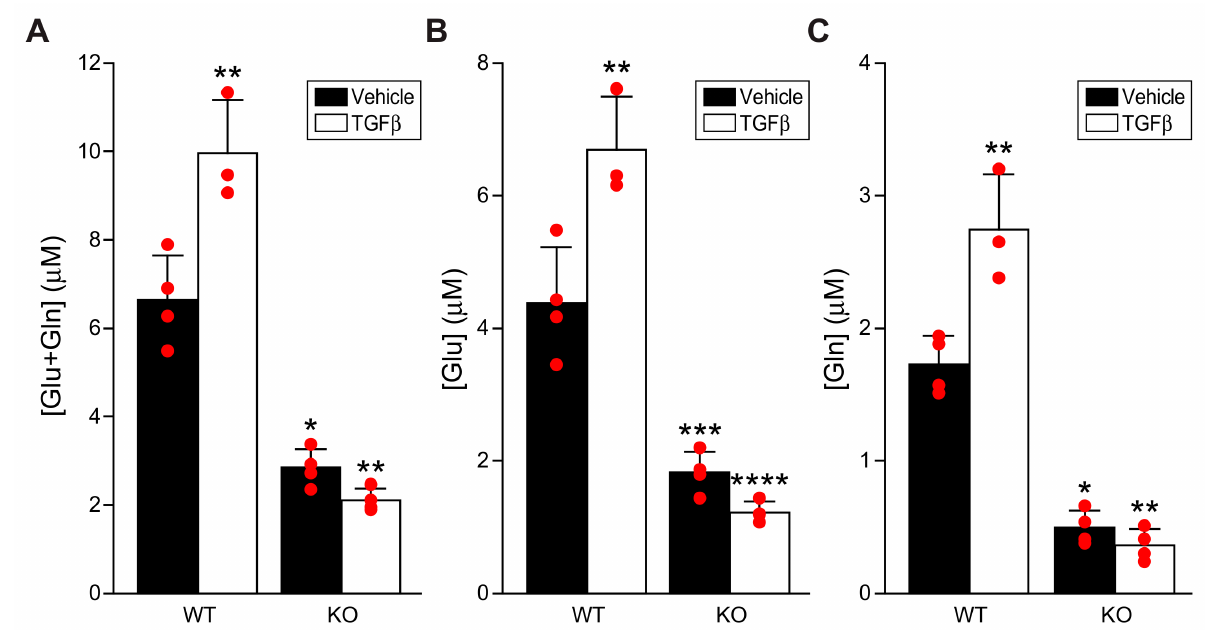
Figure 4. Loss of scleraxis attenuates TGF β -induced glutaminolysis. ( A – C ) Cardiac fibroblasts were isolated from wild-type (WT) or scleraxis knockout (KO) mice, treated with vehicle or TGF β 1 (10 ng/mL) for 24 h, and assayed for intracellular [glutamate + glutamine] ( A ), [glutamate] ( B ), and [glutamine] ( C ). Statistical analysis was by two-way ANOVA with the Tukey post hoc test (n = 3–4). * p < 0.05, ** p < 0.01, *** p < 0.001, **** p < 0.0001 versus WT +